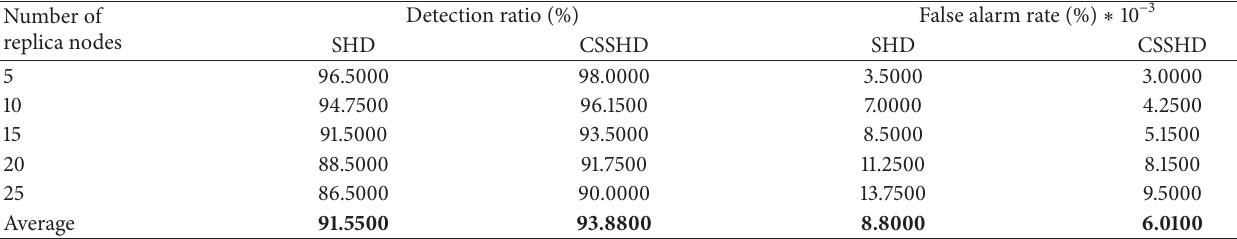
Table 4: Performance of proposed and the existing based on the number of